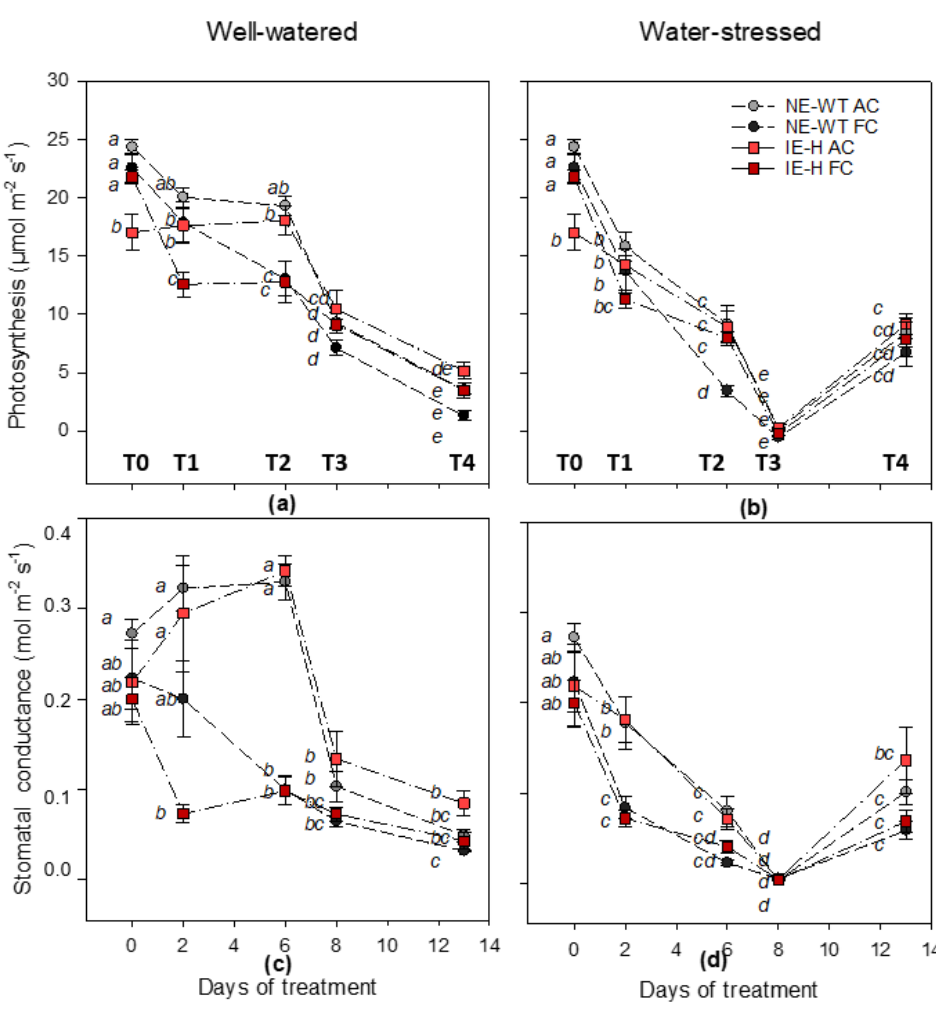
Figure 1. Photosynthesis and stomatal conductance time courses. Photosynthesis ( a , b ) and stomatal conductance ( c , d ) of non-emitting wild-type = NE-WT (triangles; circles) and isoprene-emitting line = IE-H (diamonds; squares) in actual climate scenario (AC: 400 ppmv and 28 °C; light grey = NE-WT and light red = IE-H) and future climate scenario (FC: 600 ppmv and 32 °C; dark grey = NE-WT and dark red = IE-H) in well-watered WW ( a , c ) and water-stress WS ( b , d ) conditions. Measurements were carried out before imposing the stress at day 0 (= T0), after 2, 6 and 8 days of water stress (WS; T1, T2 and T3, respectively), and after 5 days of recovery by re-watered plants (day 13 = T4). Control plants in well-watered conditions (WW) were also measured along the same time course. Means ( n = 5) + SE are shown for each data point. For each treatment (WW, WS) a one-way ANOVA followed by a Tukey’s test was performed to define the statistical significance ( p < 0.05) of mean differences along the time course of the experiment between genotypes (NE-WT, IE-H) in different climate conditions (AC, FC). Different letters show statistically significant differences.